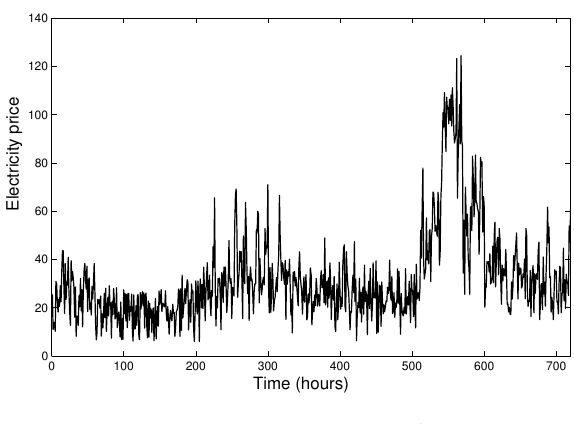
Figure 1. Time series